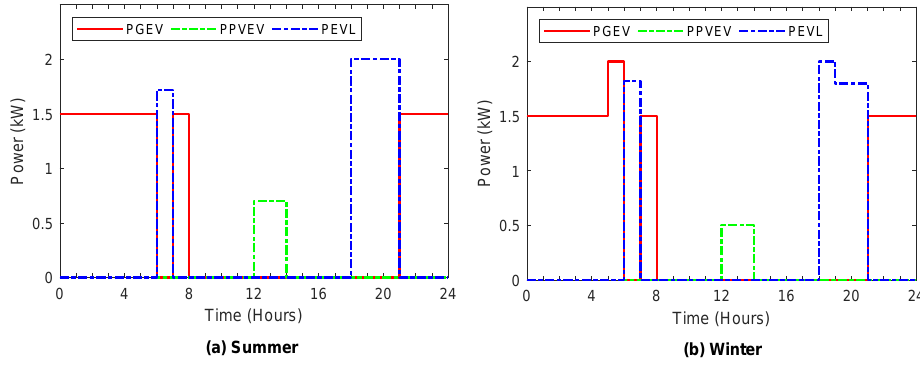
Figure 8. Optimal power flows from/to electric vehicle during summer and winter. Figure 9a,b illustrate procured power from the grid to feed the load demand, ESS, and EV in summer and winter, respectively. According to Figures 9a,b procured power from the grid was reduced during the high electricity price intervals and increased during low electricity prices, which minimized the household’s total cost.